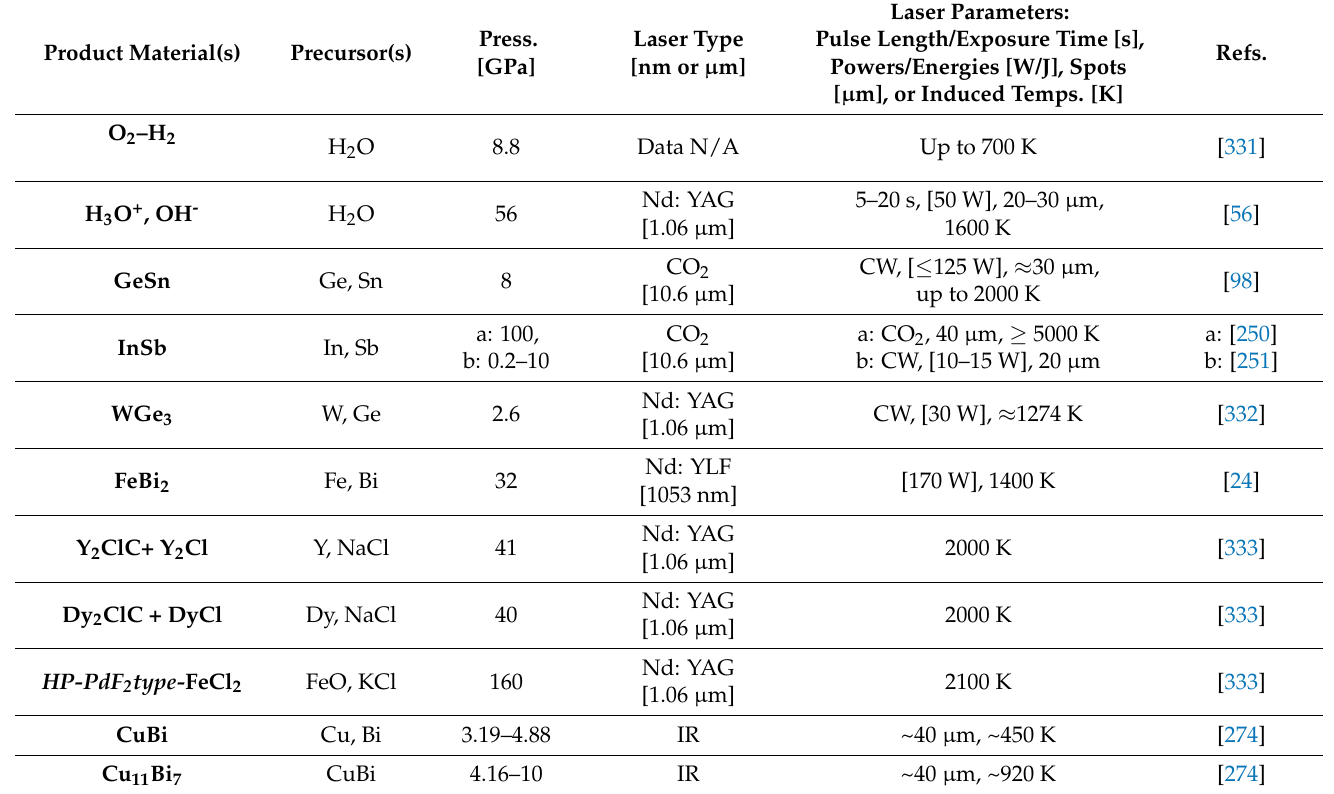
Table 10. Intermetallics and Metallic Compounds: Metallic Compounds and Intermetallics Synthe- sised During Selected LRS-DAC